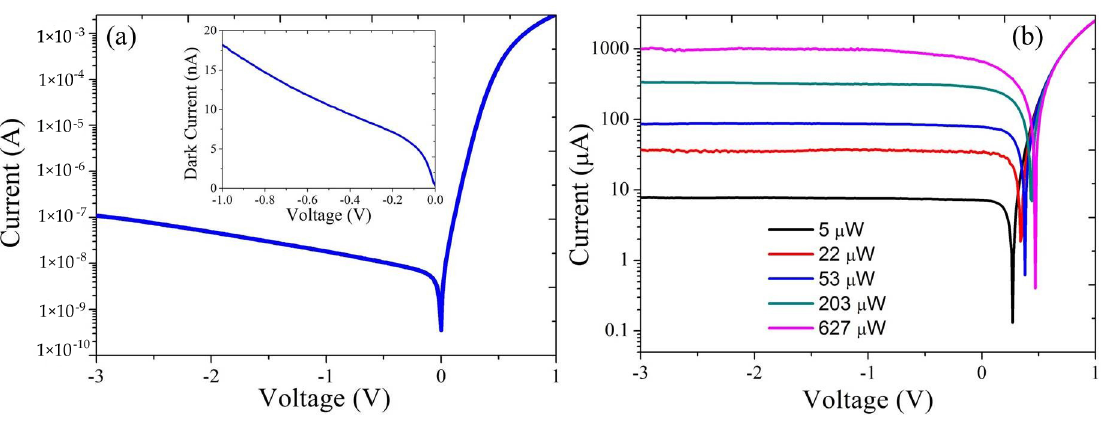
Figure 9. ( a ) I-V curve of the heterogeneously integrated adiabatic-taper-based photodetector in the dark, the inset shows the dark current of the device from − 1 V to 0 V; ( b ) I-V curve of the photodetector under different waveguide-coupled input powers at a wavelength of 2.35 µ